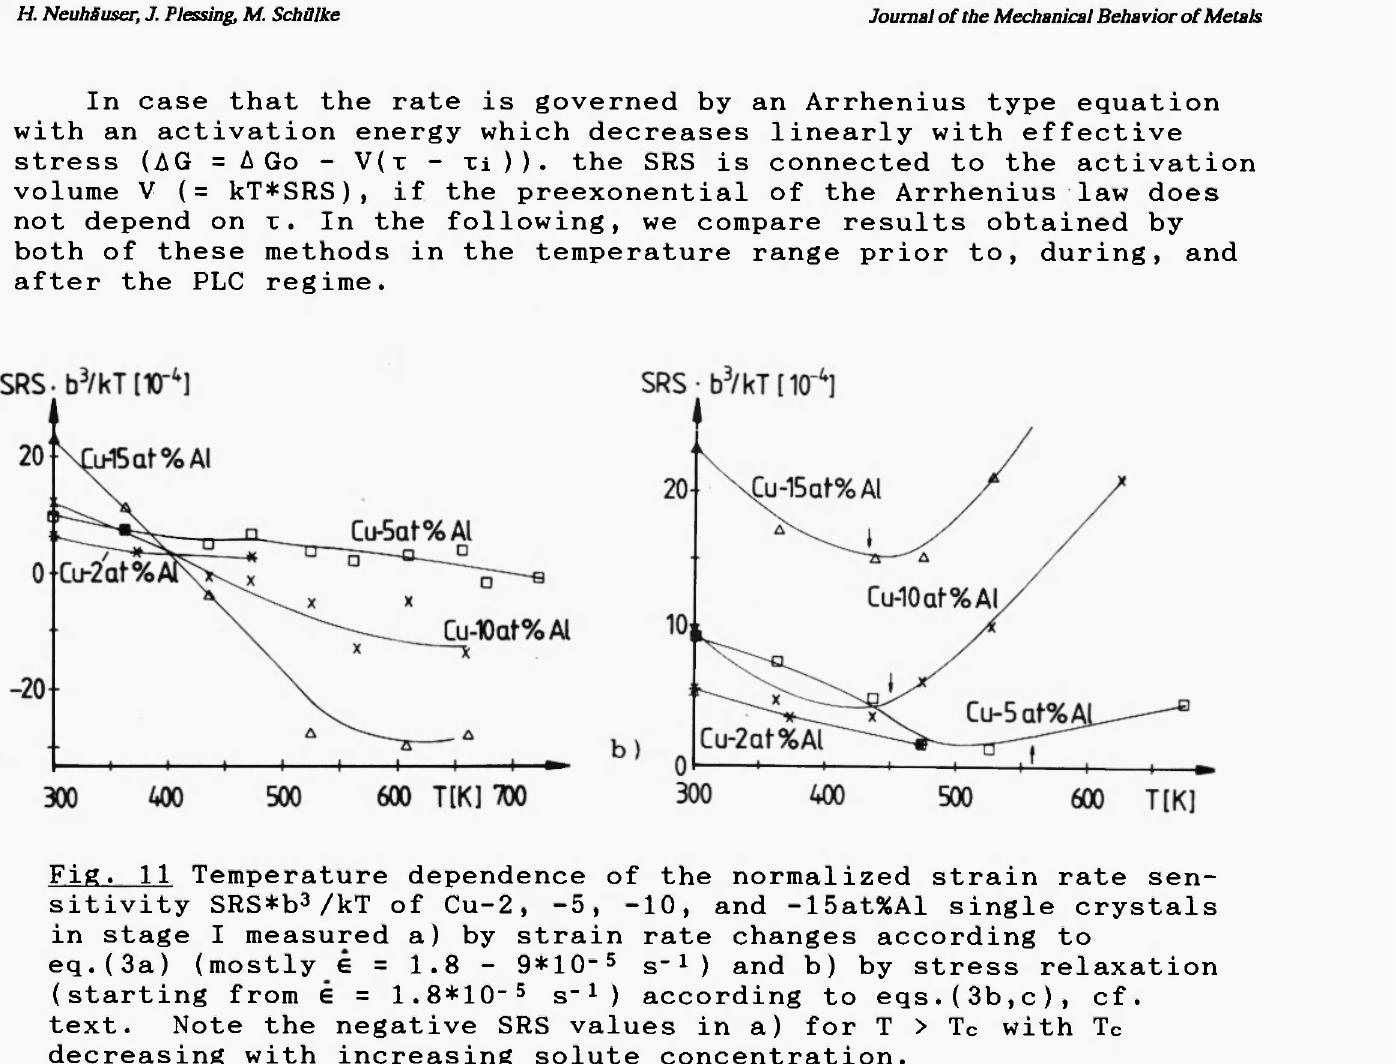
Fig. 11 Temperature dependence of the normalized strain rate sen- sitivity SRS*b 3